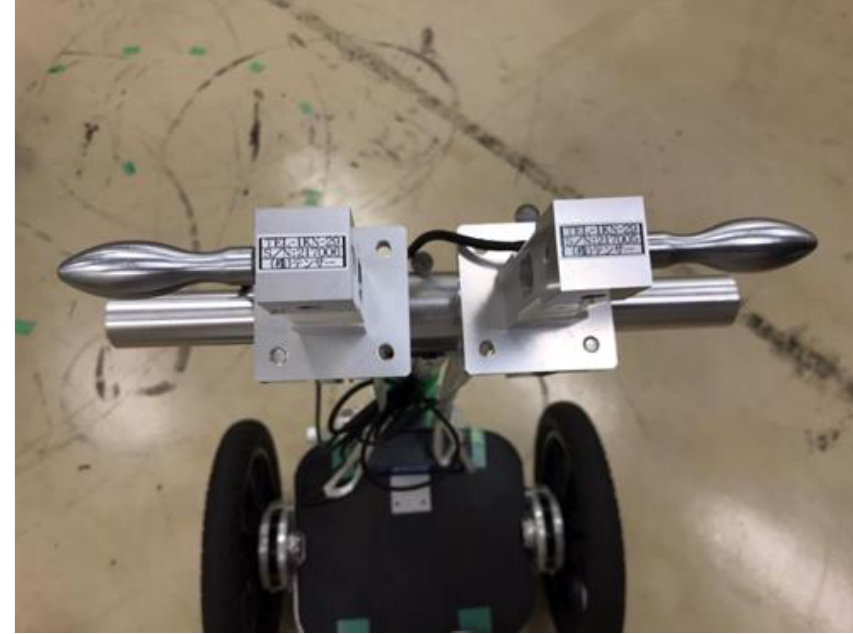
Figure 13. Schematic of a rigid link.